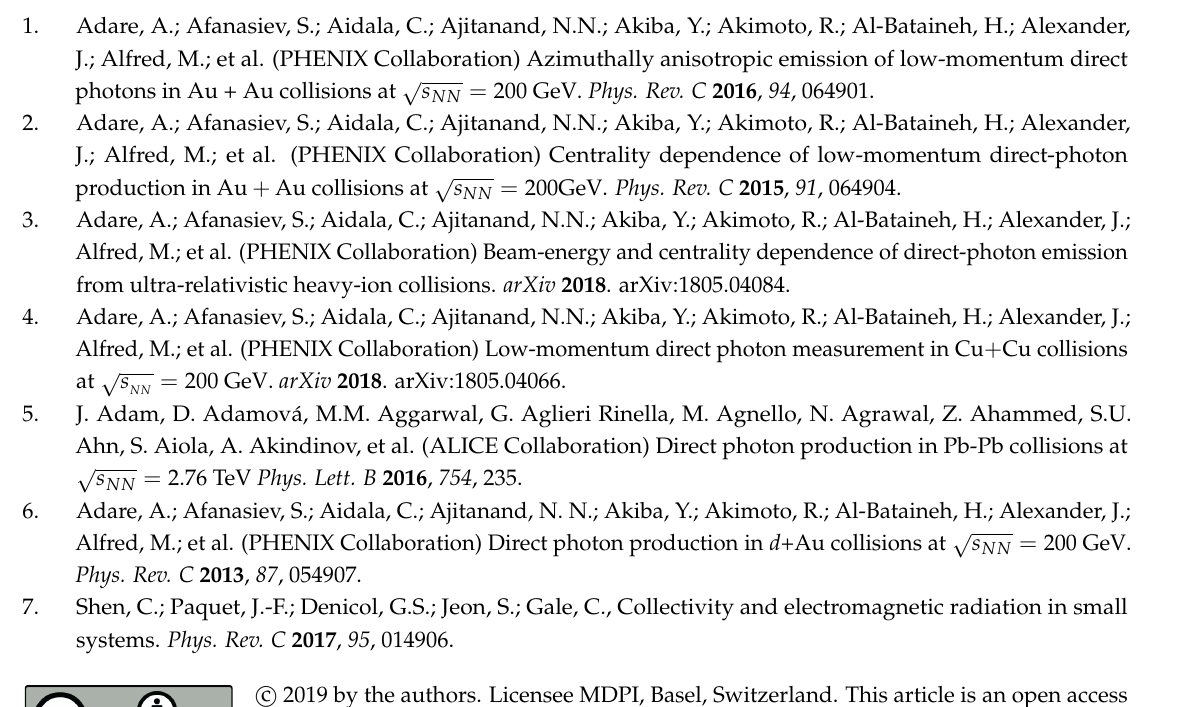
Figure 4. R p + Au vs p T for p+Au collisions at photon yield integrated above 1 GeV/ c vs dN ch / d η , compared with the large system data from small systems ( right